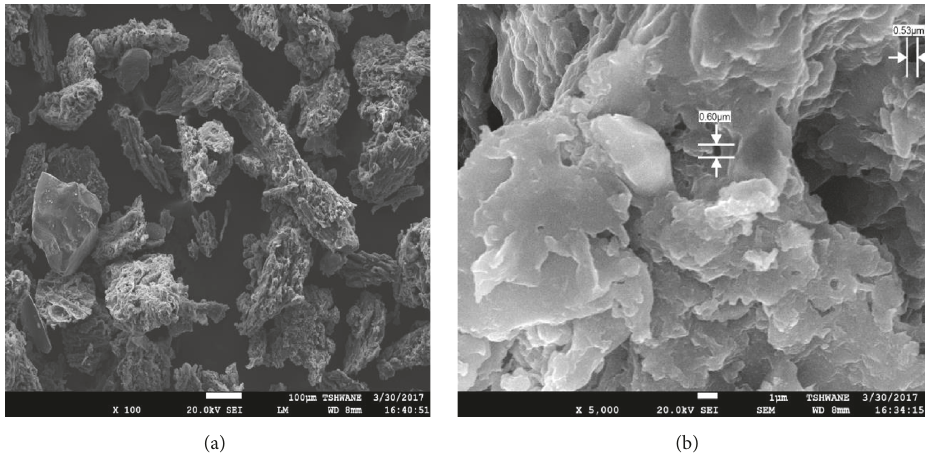
Figure 12: (a) Overview of 𝐴 4∗ from SEM analysis; (b) pore size distribution of 𝐴 4∗ at × 5000